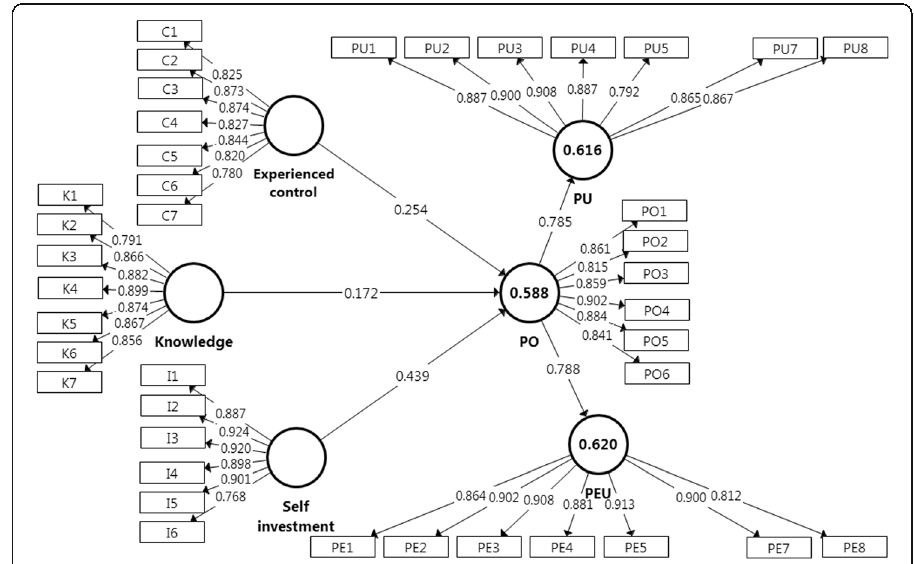
Fig. 5 Structural model with path coefficients ( β ) and R 2 for endogenous